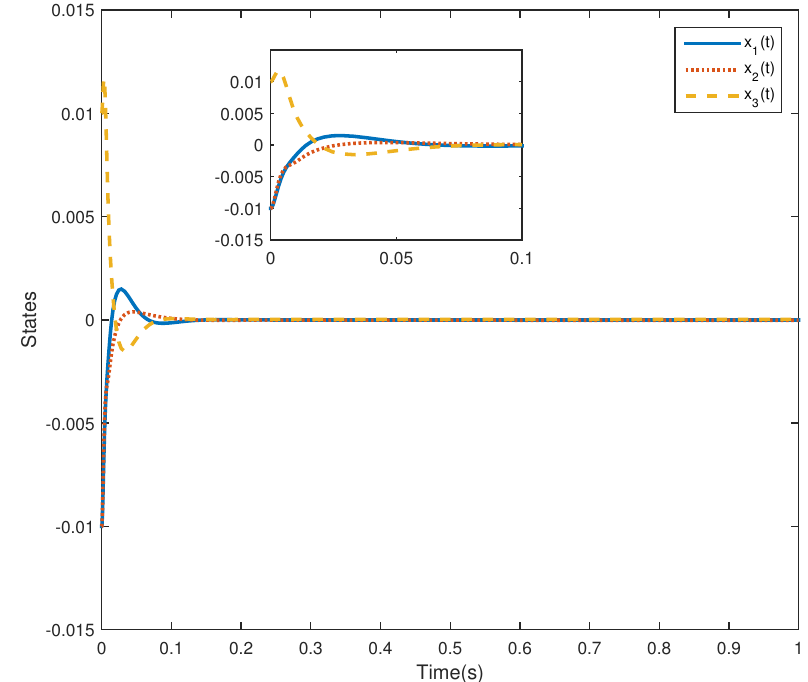
Figure 4. The closed-loop FOS in Example